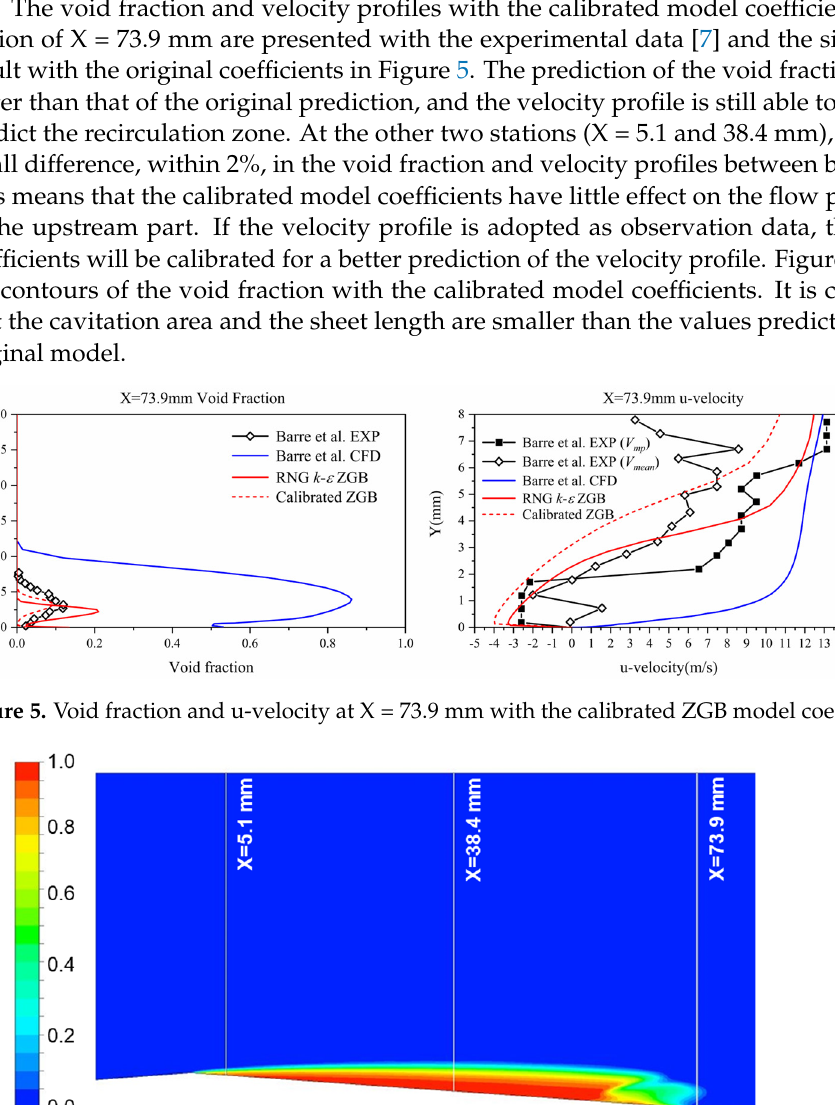
Figure 6. The void fraction contour with the calibrated ZGB model coefficients .